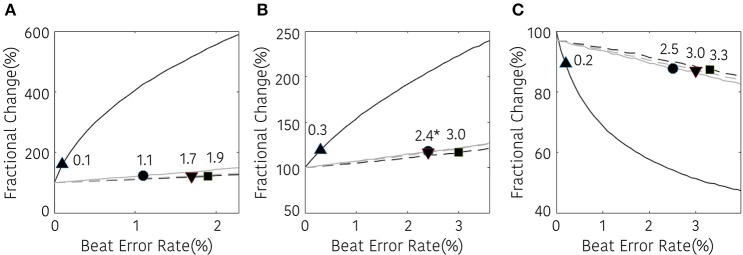
Result of non-linear HRV analysis according to the beat error rate. The number in the figure represents the beat error rate that begins a significant difference. The dark solid line, bright solid line, dark dashed line, bright dashed line indicate non-interpolated, NNI, LI, and CSI, respectively. (A) SD1, (B) SD2, (C) ApEn (▴, •,■, ▾) represent the position of error rates that start to have a statistically significant difference compared to the HRV variable derived with ectopic-free IBIs.